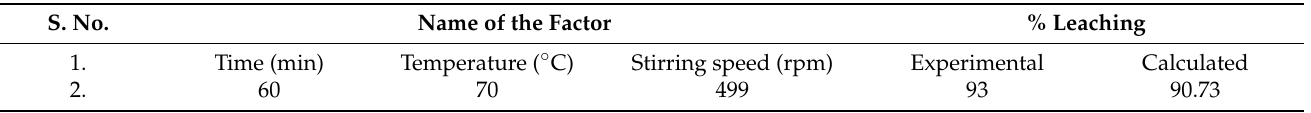
Table 5. Validation of calculated results with experimental results for gold